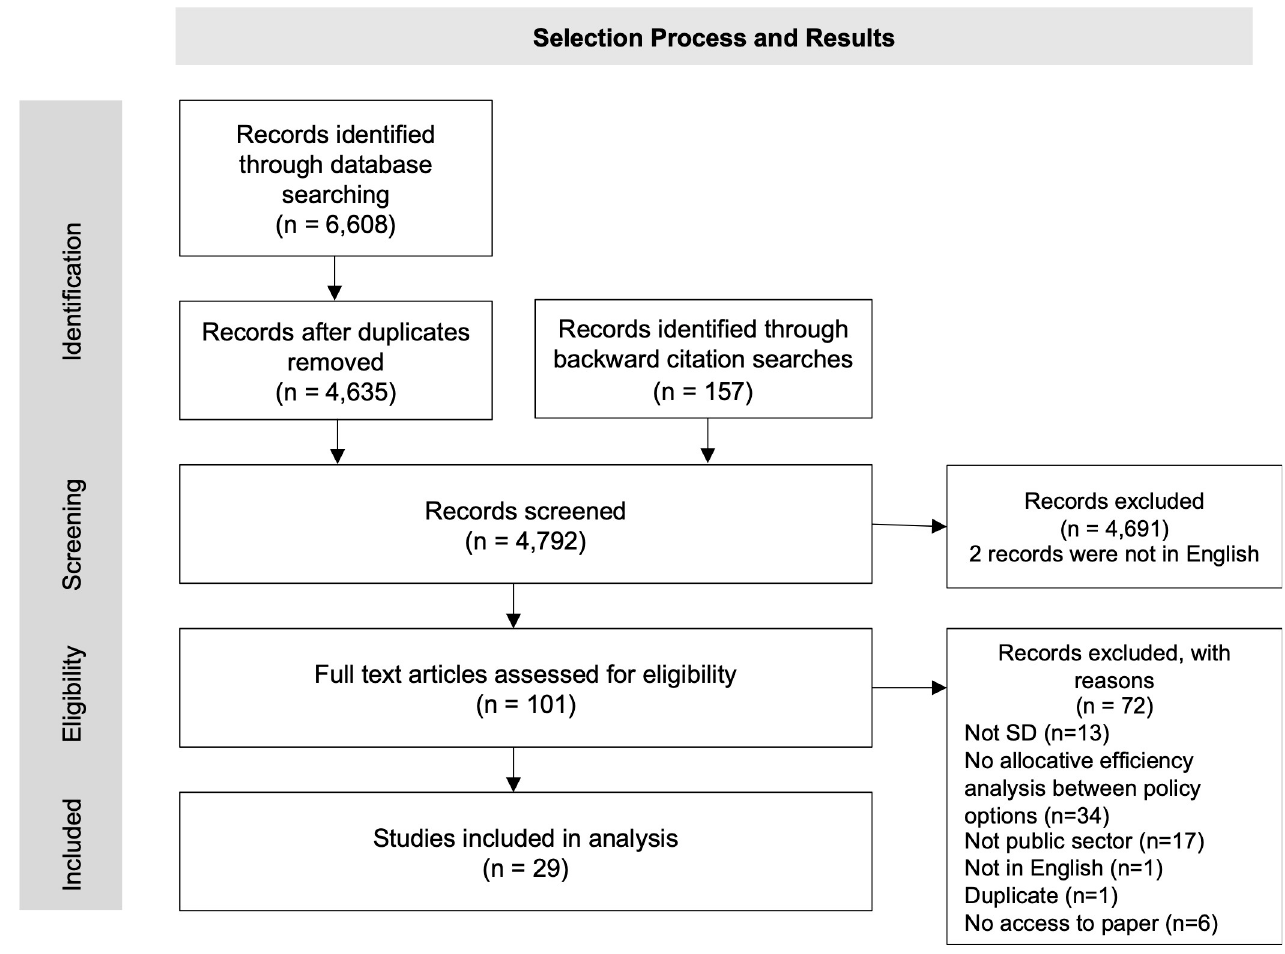
Fig 1. Selection process and results.